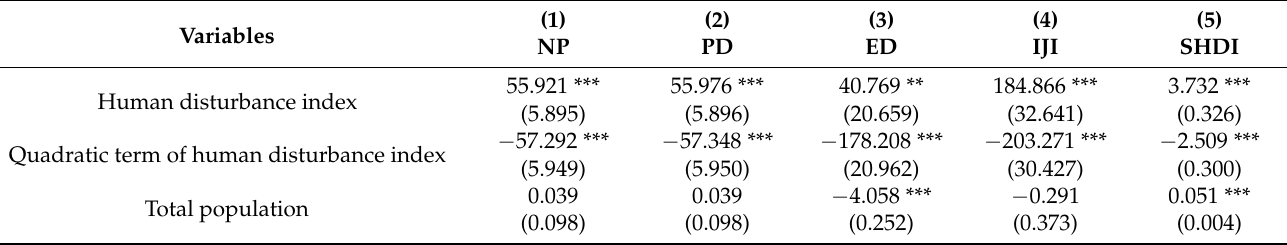
Table 11. Regression results of the influence factors on the landscape